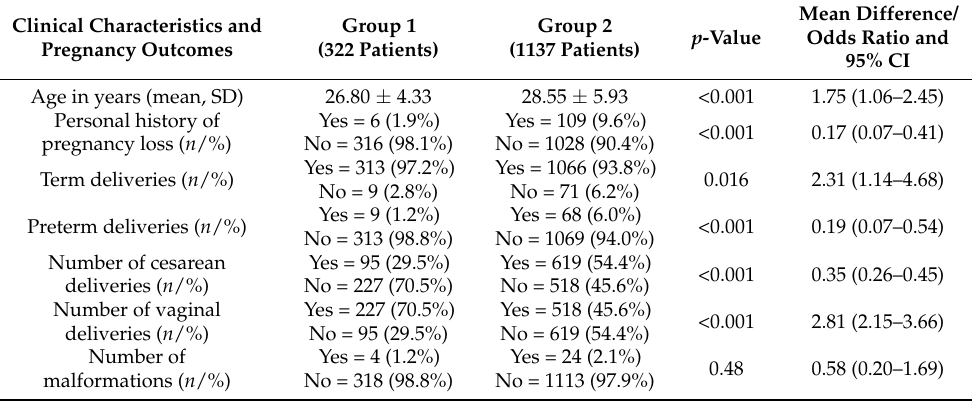
Table 1 legend: SD—standard deviation; CI—confidence interval.